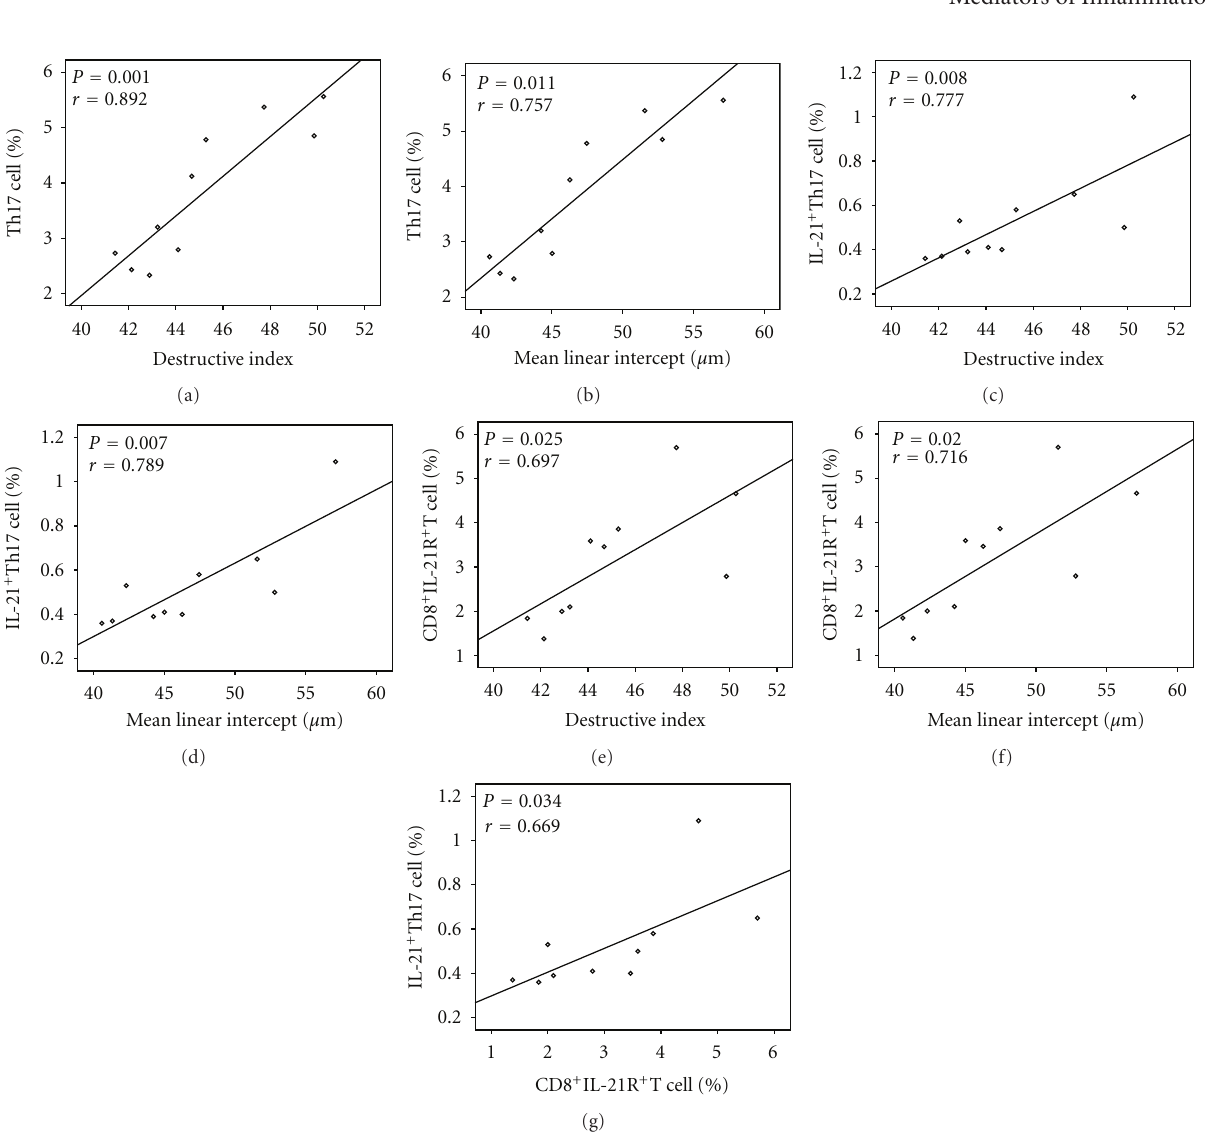
Figure 6: Correlations between (a) the frequency of CD4 + IL-17 + Th17 cells in peripheral blood and DI, (b) the frequency of CD4 + IL- 17 + Th17 cells in peripheral blood and Lm, (c) the frequency of IL-21 + Th17 cells in peripheral blood and DI, (d) the frequency of IL-21 + Th17 cells in peripheral blood and Lm, (e) the frequency of CD8 + IL-21R + T cells in peripheral blood and DI, (f) the frequency of CD8 + IL-21R + T cells in peripheral blood and Lm, and (g) the frequency of CD8 + IL-21R + T cells and the frequency of IL-21 + Th17 cells in peripheral blood. Data were determined by Pearson’s rank correlation coe ffi